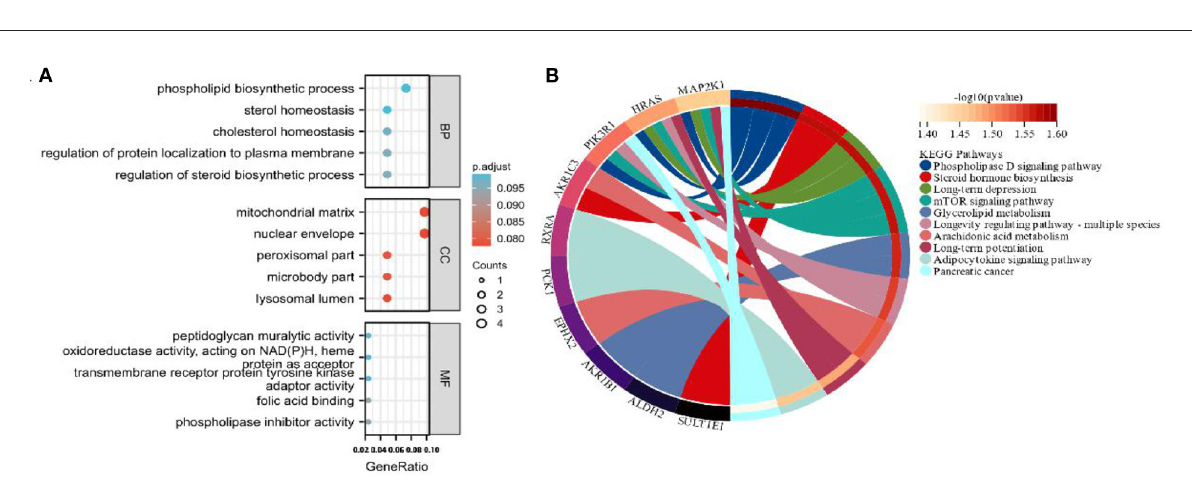
FIGURE11 (A,B) GO and KEGG enrichment analyses for DEGs, terms with p and q < 0.05 were believed to be enriched significantly.